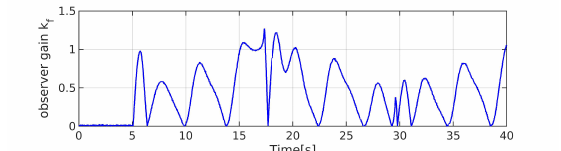
Figure 7. Observer gain of FASTESO during adaptation process with scalar a = 10.